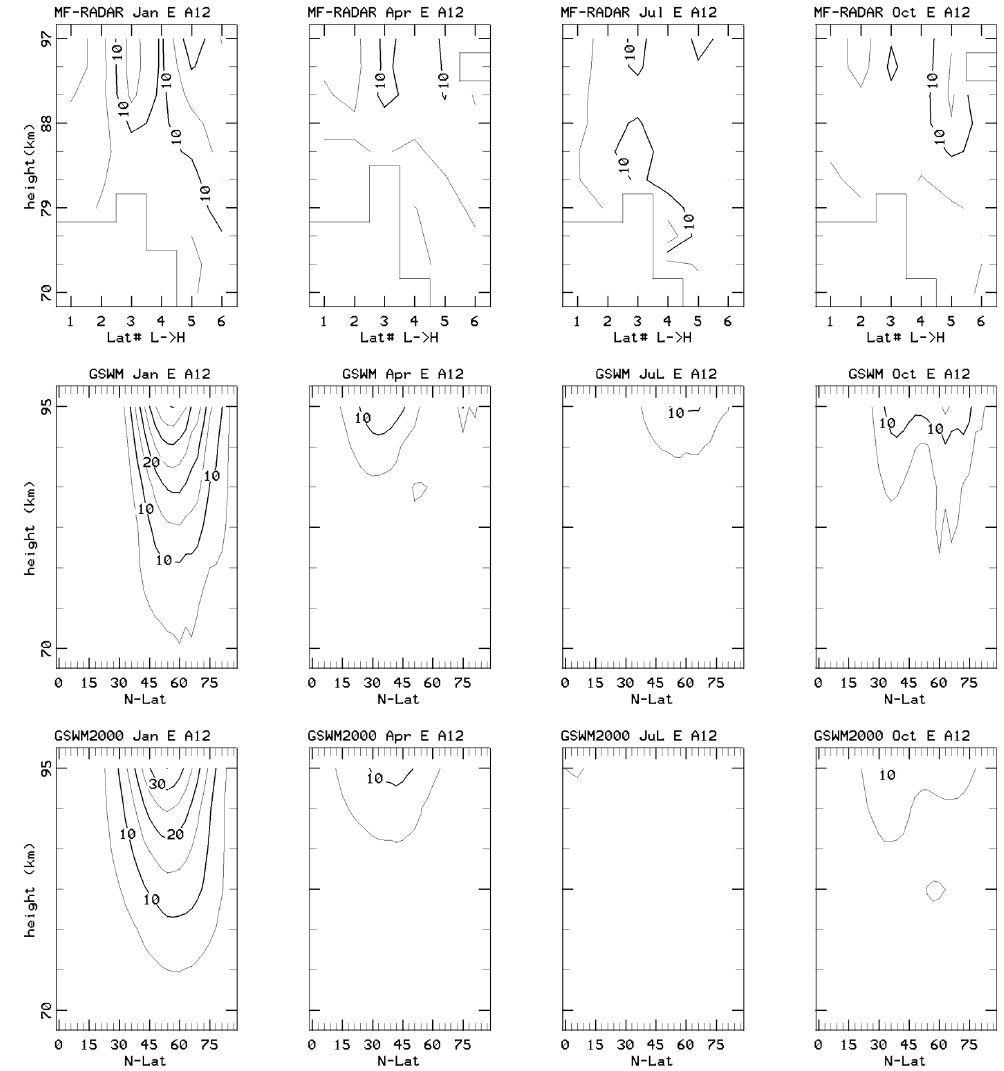
Fig. 4. Amplitude (A12) contour plots for the zonal component of the 12h Tide. Plots are shown for the MFR systems (Latitude numbers 1–6; Christmas Island, Hawaii, Urbana, London, Saskatoon and Tromsø), the GSWM, and the GSWM2000. The numbers on the lines are in m/s; +ve meaning toward the